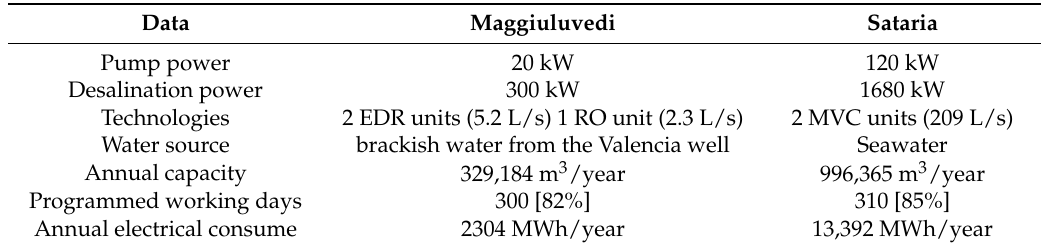
Table 2. Main data of desalination plants installed in